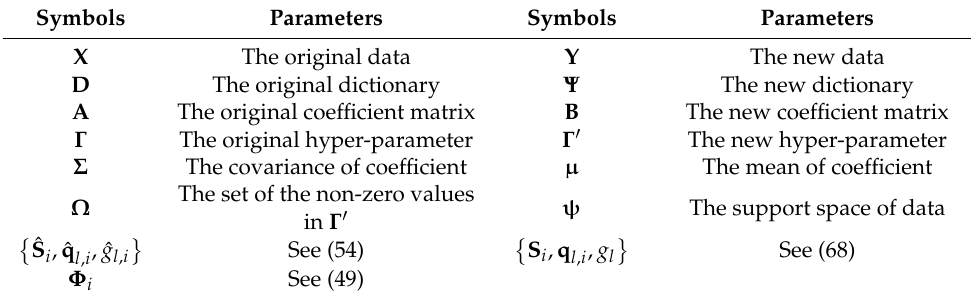
Table 1. The main